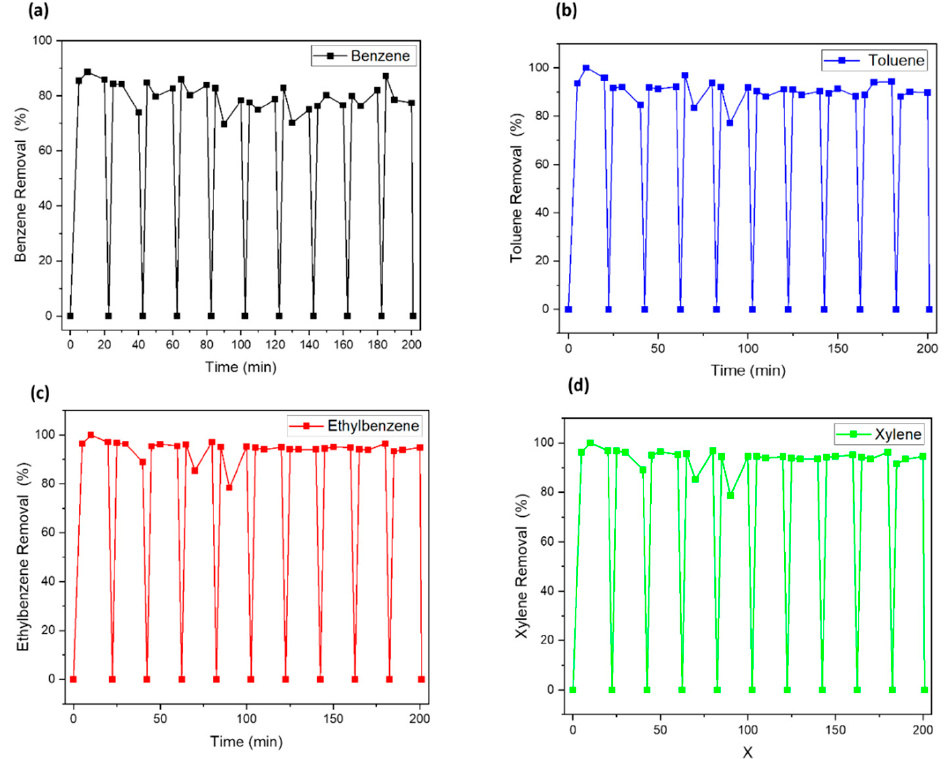
Figure 9. BTEX removal by UV–Fe 2 O 3 -Mn 2 O 3 /SiO 2 : ( a ) benzene, ( b ) toluene, ( c ) ethylbenzene, ( d )